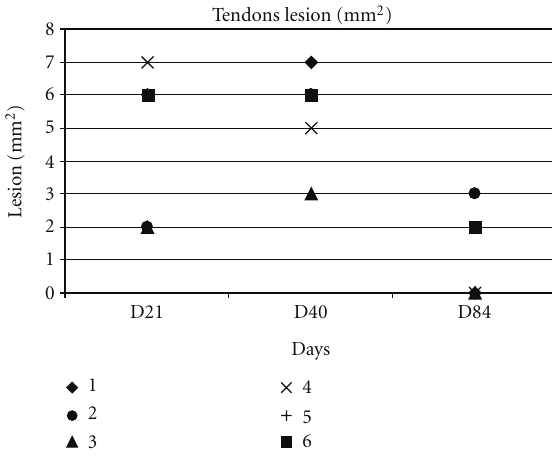
Figure 7: Change in measurements of tendon’s